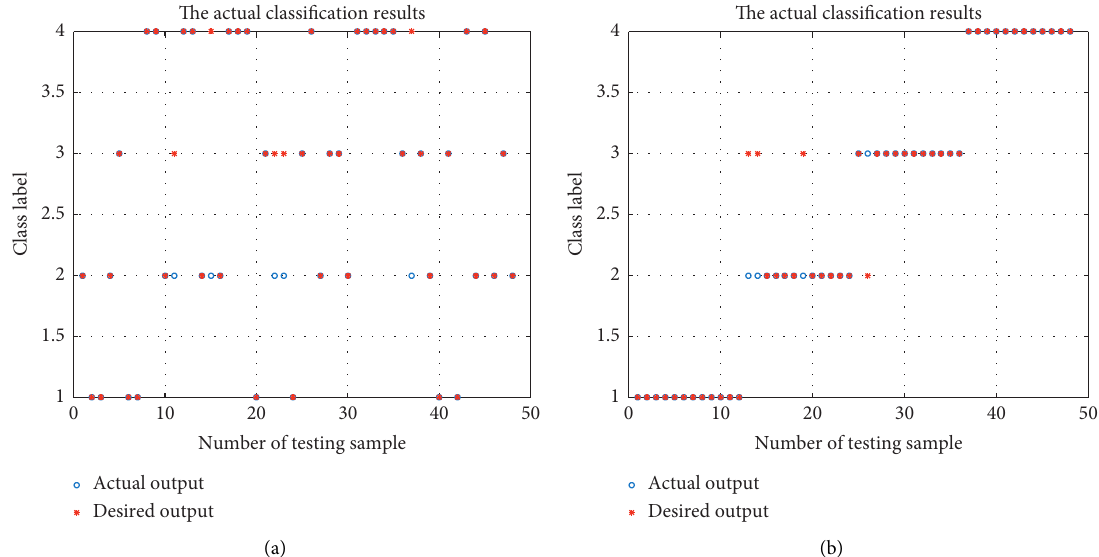
Figure 15: Recognition result of the experimental signal based on singular spectral entropy. (a) SVM model. (b) PSO-SVM model.